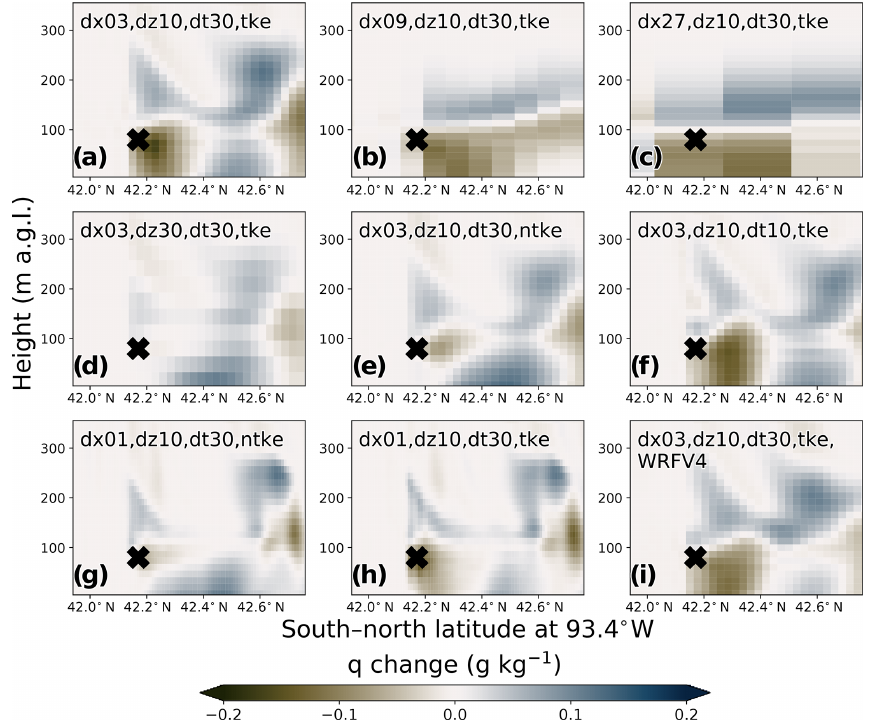
Figure 15. Vertical cross sections of water vapor mixing ratio ( q ) changes resulting from the presence of the wind farm in the tested simulations on 26 August 02:00UTC (25 August 21:00LT). The median location and hub height of the wind farm is denoted by the black X. Location of this slice is denoted by the dashed line in Fig.